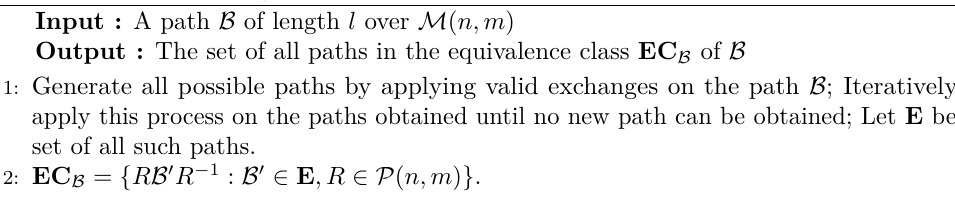
Algorithm 1 Generating Paths in an Equivalence